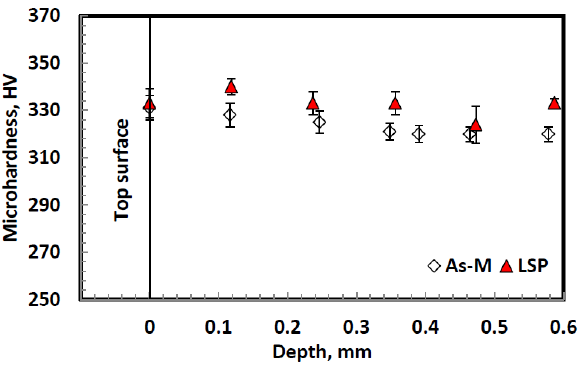
Figure 9. Measured microhardness with respect to depth for LSP and As ‐ M conditions.